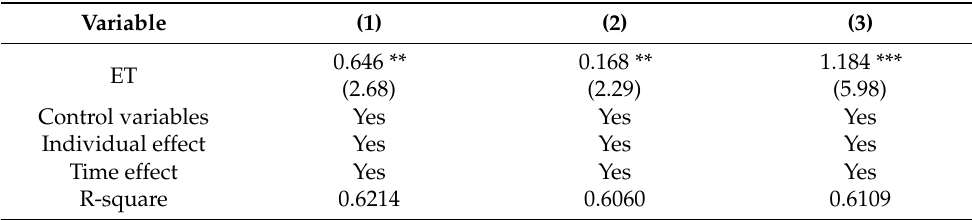
Table 3. Results of the robustness